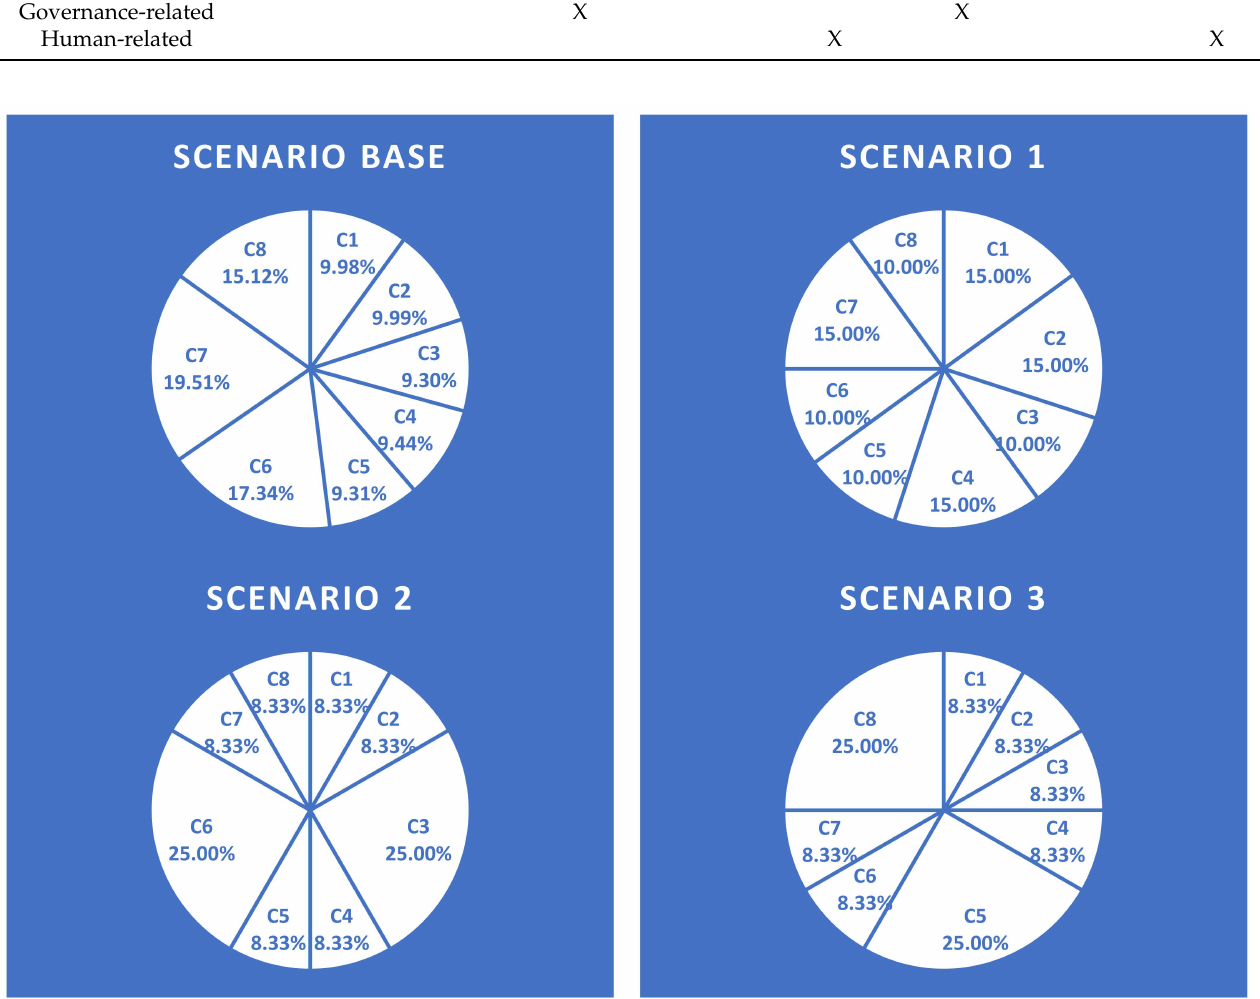
Figure 5. Indicator weighting